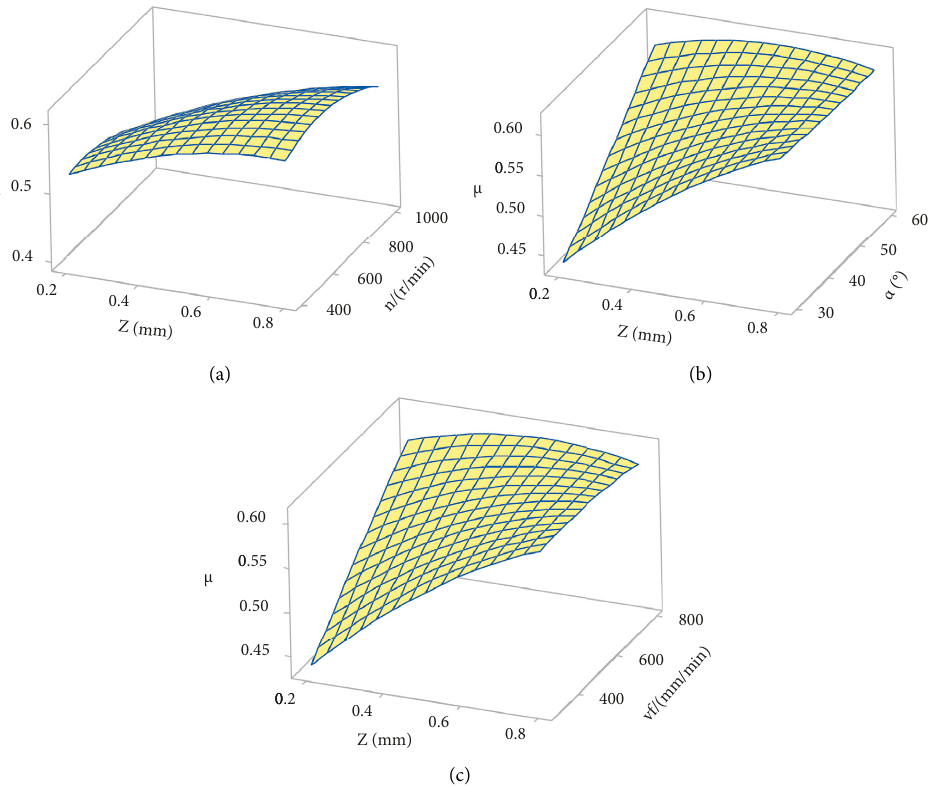
Figure 18: RS for Z interacting with n , α , and vf, respectively. (a) μ � f ( Z , n ). (b) μ � f (Z, α ). (c) μ � f ( Z , vf).